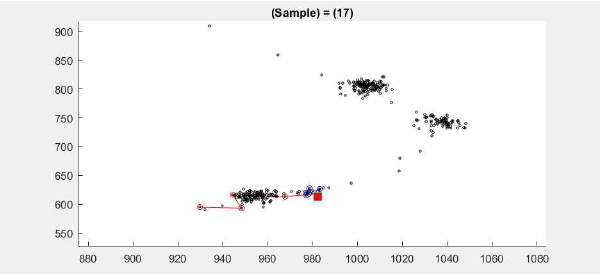
Figure 13 . Position plot for dataset 2.1 at samples 242– 246 (red line at sample 242) shows a small jump in the mean after a period of data